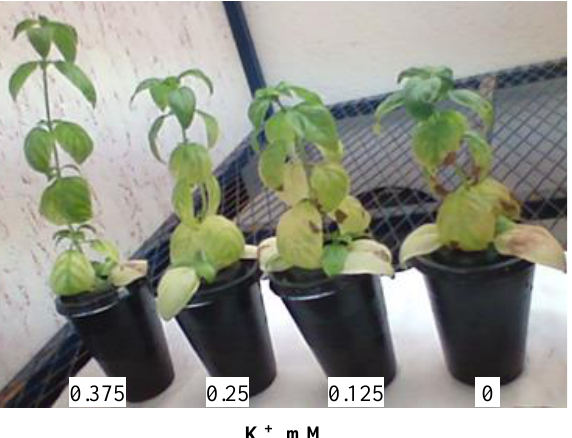
Figure 1. Morphology of 64-day-old O. basilicum plants after 30 days of culture in the presence of varying K + concentrations.